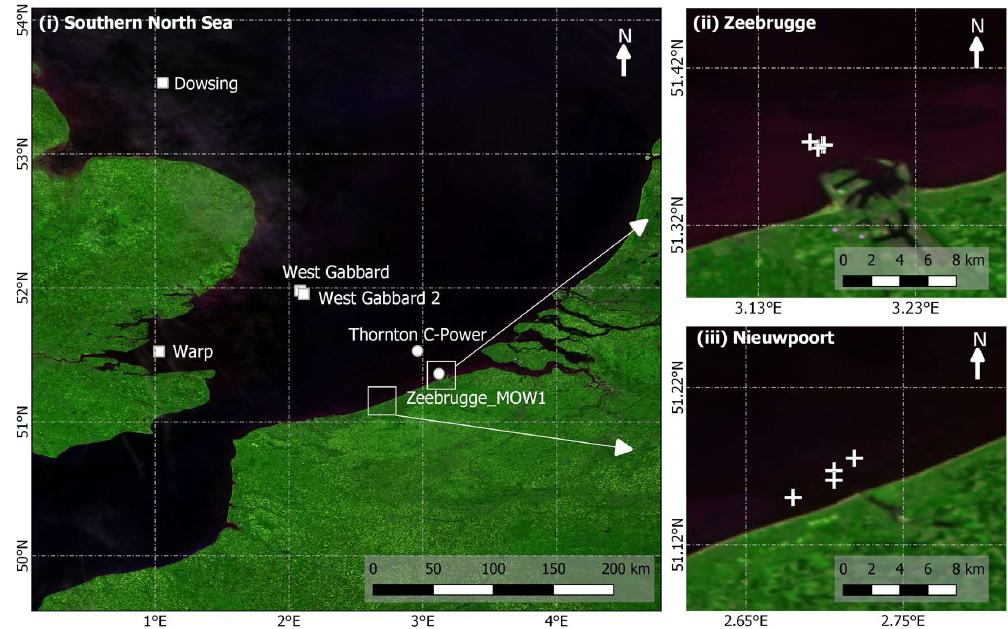
Figure 2. Reference data used for the PROBA-V products validation, consisting of ( i ) two AERONET-OC stations: Thornton C-Power and Zeebrugge_MOW1 (dots), four CEFAS SmartBuoys: Dowsing, Warp, West Gabbard and West Gabbard2* (rectangles) and sampling from the RHIB Zeekat during field campaigns in ( ii ) Zeebrugge and ( iii ) Nieuwpoort (crosses).*The position of WestGabbard is slightly changed in May 2016; since then referred to as West